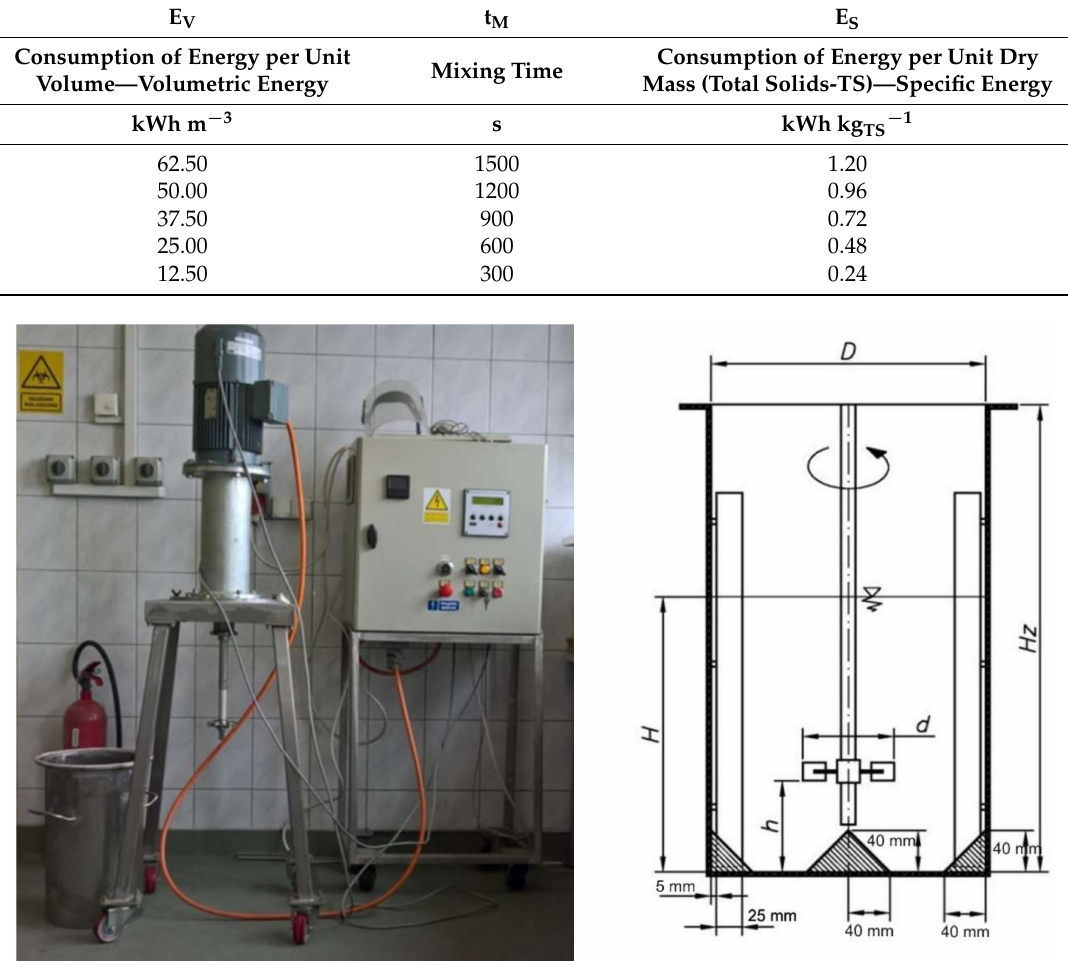
Table 3. Parameters of the mechanical disintegration—semi-technical sludge disintegrating mixer. E V t M E S Consumption of Energy per Unit